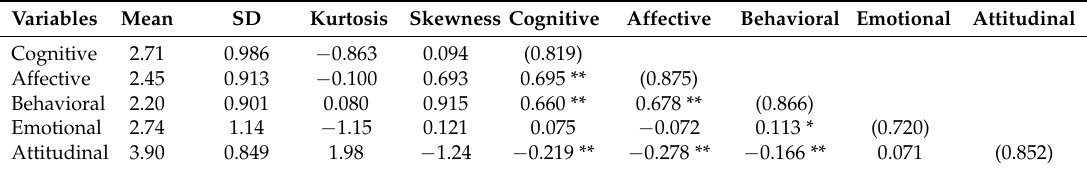
Table 3. Descriptive statistics, correlations, and reliability.